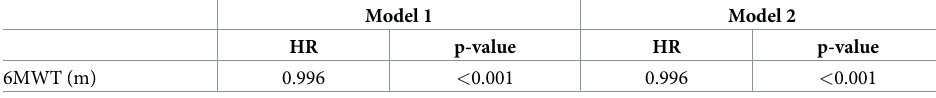
Table 4. Adjusted competing risks regression model for mortality.